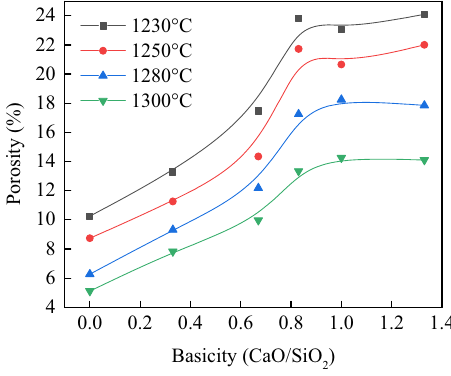
Figure 2: E ff ect of basicity on the porosity of fi red briquettes.